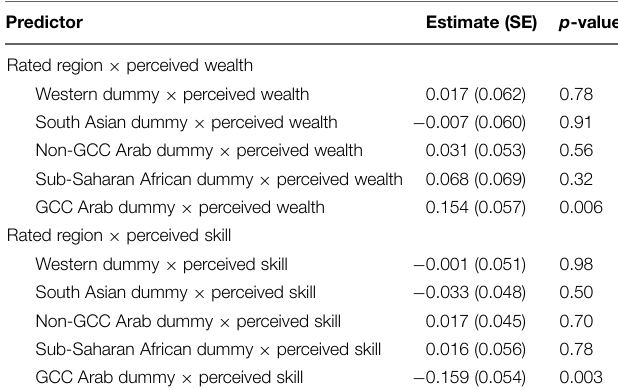
TABLE 8 | Interaction coefficients from model testing the moderating effects of the rated region. Predictor